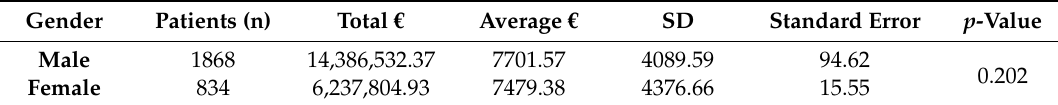
Table 3. Cost by